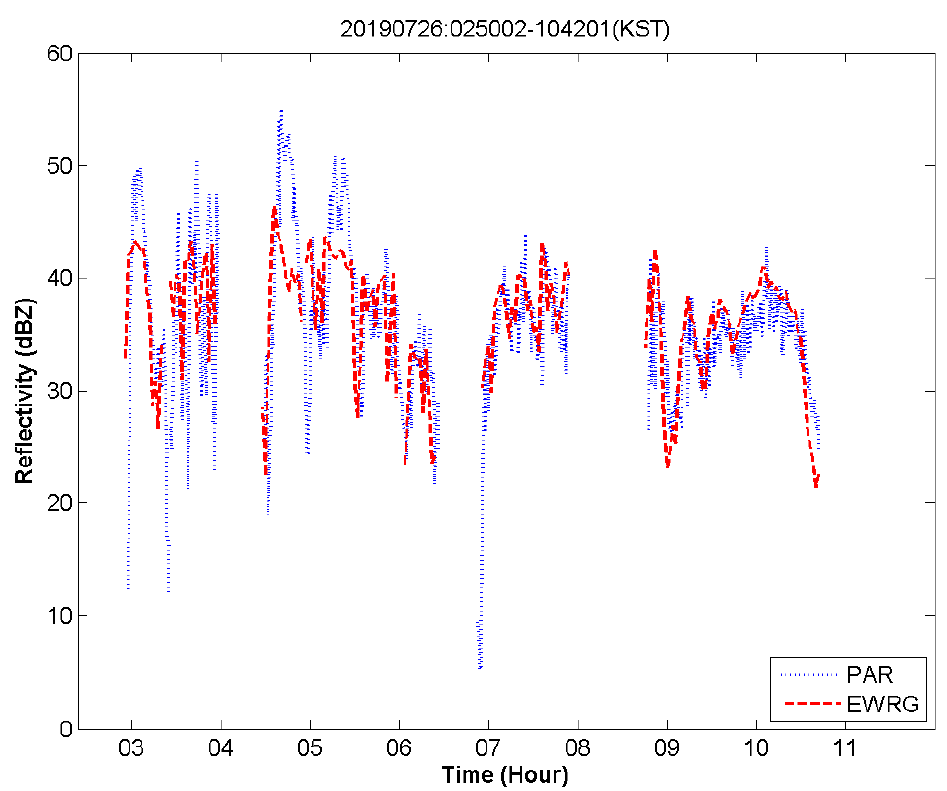
Figure 4. An example of Z h comparison results of EWRG and Parsivel after Z h calibration.